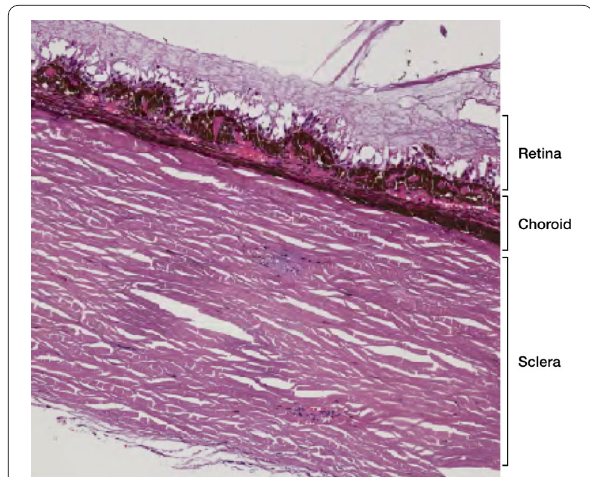
Fig. 4 Histological detail illustrating a full-thickness section of the posterior wall of the eye, consisting of three layers (from outer to inner): sclera, choroid and retina (H&E, original magnification